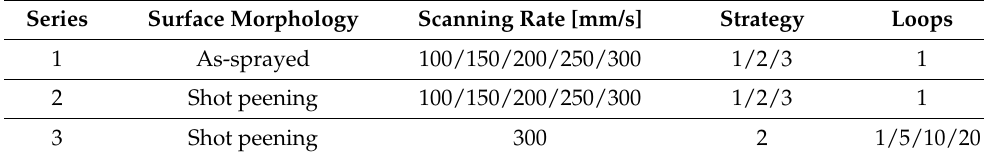
Table 2. Variable laser process